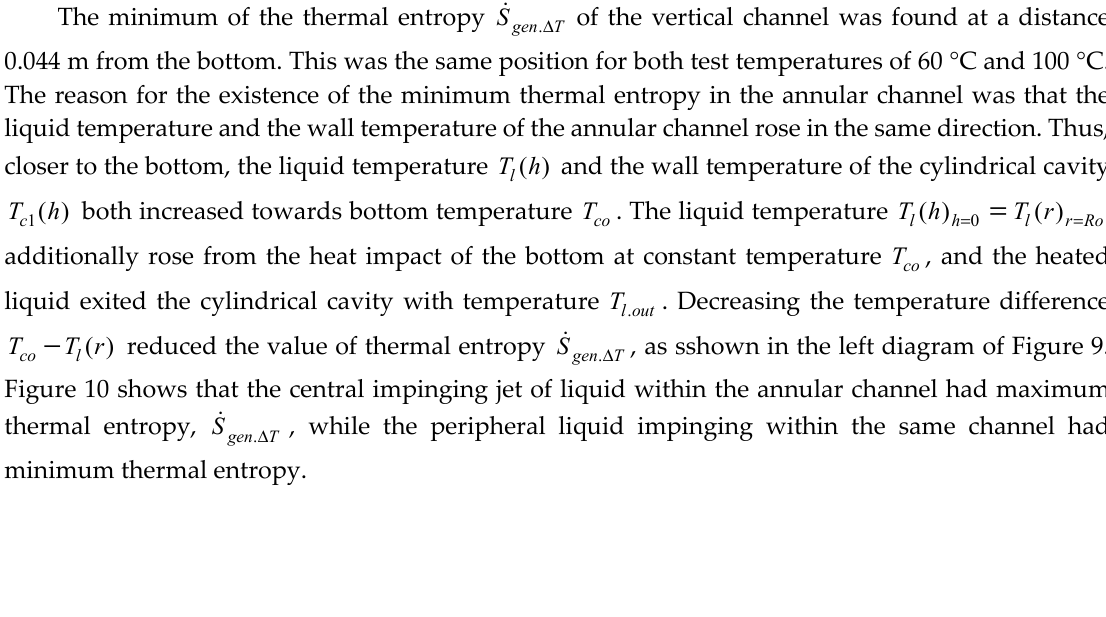
 of the vertical channel was found at a distance S Δ Tgen . and the wall temperature of the cylindrical cavity l = T . The liquid temperature rThT == )()( co Rorlhl 0 T , and the heated co T . Decreasing the temperature difference outl . , as sshown in the left diagram of Figure